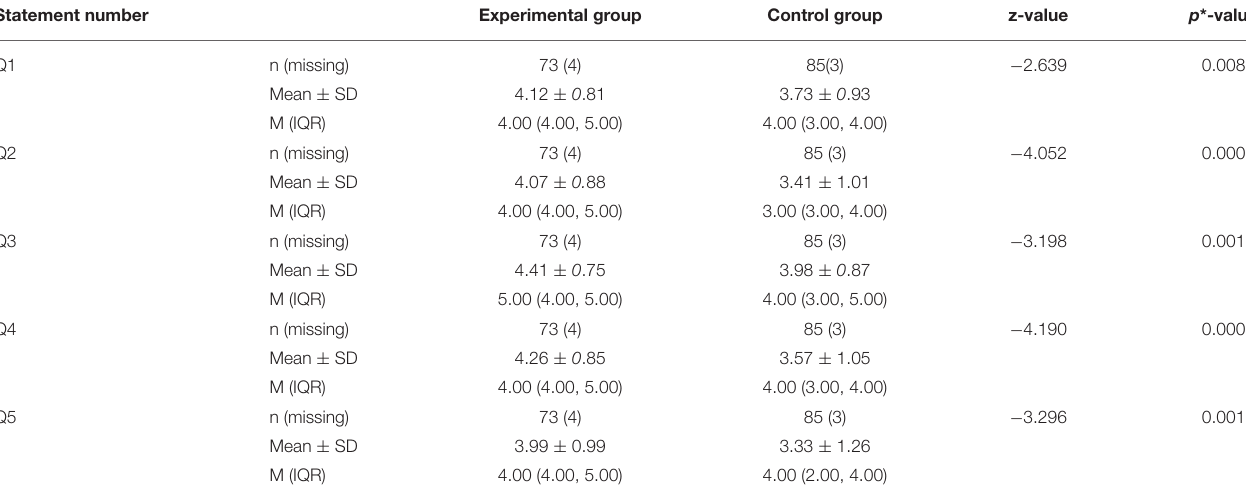
TABLE 4 | Comparison of course evaluation scores between flipped classroom based on micro-video class and traditional model. Statement